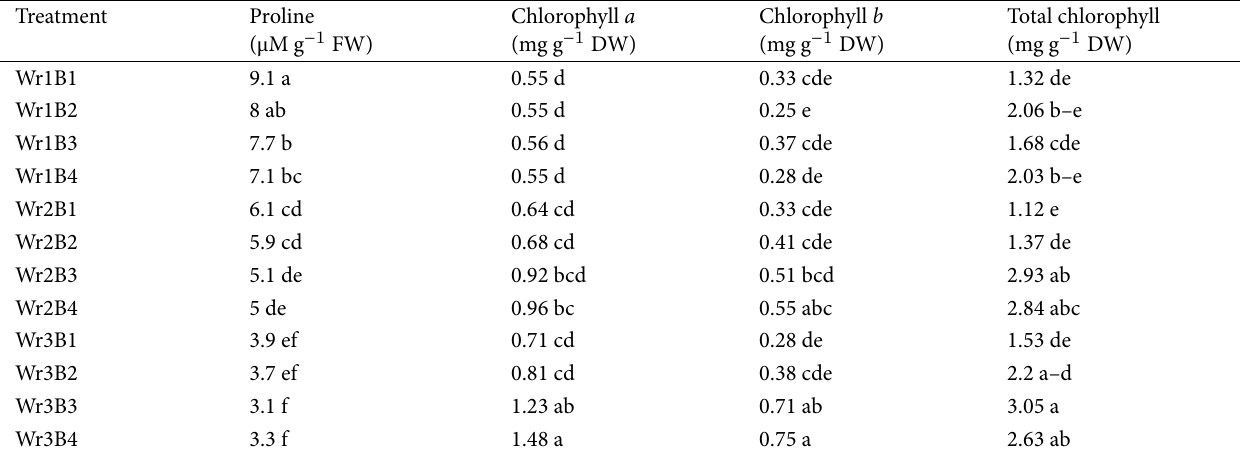
Mean values with the same letters are not significantly different at p ≤ 0.05 according to LSD